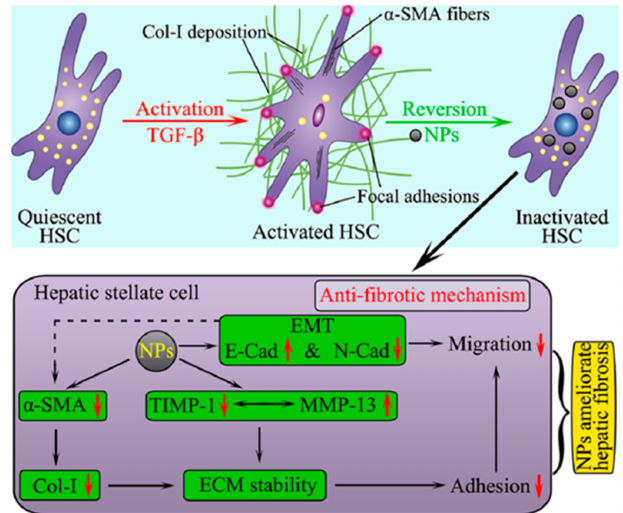
Figure 3. Model for TiO 2 NPs and SiO 2 NPs ameliorated fibrosis, adhesion and migration of HSCs. TiO 2 NPs and SiO 2 NPs can suppress the expression of α -SMA and deposition of Col-I induced by TGF- β . ECM was degraded by upregulating MMP-13 and downregulating TIMP-1. Therefore, adhesion of LX-2 cells was reduced. Furthermore, NPs stimulated the expression of E-Cad and reduced the expression of N-Cad, and, therefore, aggravated the migratory phenotype. Reproduced with permission from [63]. Copyright American Chemical Society,